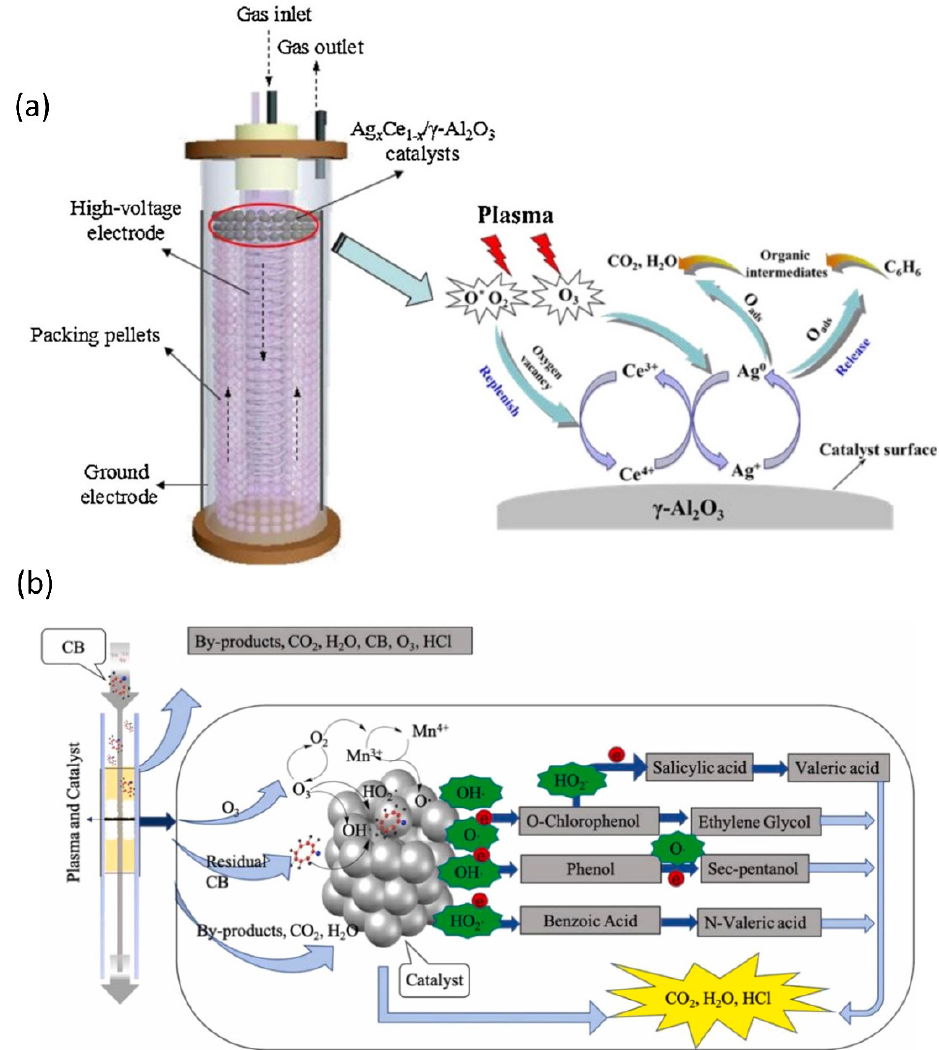
Figure 10. ( a ) Proposed synthetic catalytic mechanism for organic compound removal in the NTP + Ag x Ce 1−x /γ-Al 2 O 3 system. Reprinted with permission from Ref. [197]. Copyright 2016, Elsevier. ( b ) The most likely chlorobenzene elimination reaction pathways in the plasma-catalytic method. Reprinted with permission from Ref. [198]. Copyright 2021,